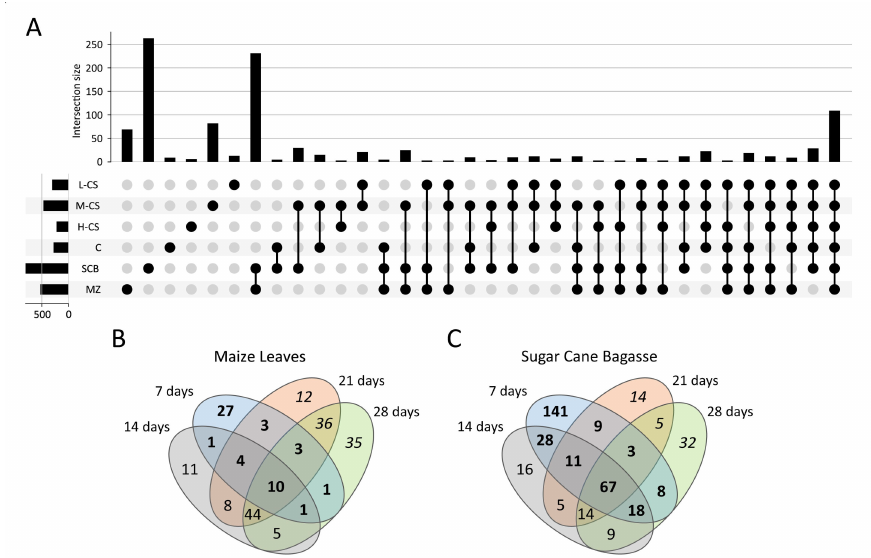
Figure 5. Co-expression of proteins detected by MS-based proteomics. ( A ) In-gel analysis of proteins found in different S. longicolleum secretomes. The connected black dots in the lower part of the figure indicate growth conditions resulting in the expression of shared sets of proteins. The number of proteins found under specific conditions is shown by the size of the black bars. The combinations are sorted to first show the unique proteins (specific for certain media) moving toward the set of proteins expressed under all conditions. From all the possible combinations, only those with more than two co-expressed proteins are shown. ( B , C ) Venn diagrams showing the FW57 secretome (in-solution analysis) at four time points for two growth conditions on ( B ) maize leaves and ( C ) sugarcane bagasse. Numbers represent the proteins expressed at the indicated time points. Numbers in bold indicate the proteins associated with early growth on the biomass, while those in italics indicate late-stage